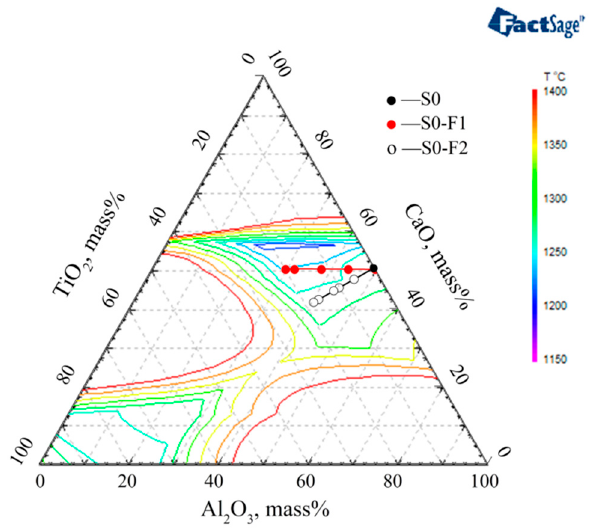
Figure 6. The phase diagram of CaF 2 -CaO-MgO-Al 2 O 3 -TiO 2 (CaF 2 = 46% and MgO = 4%).